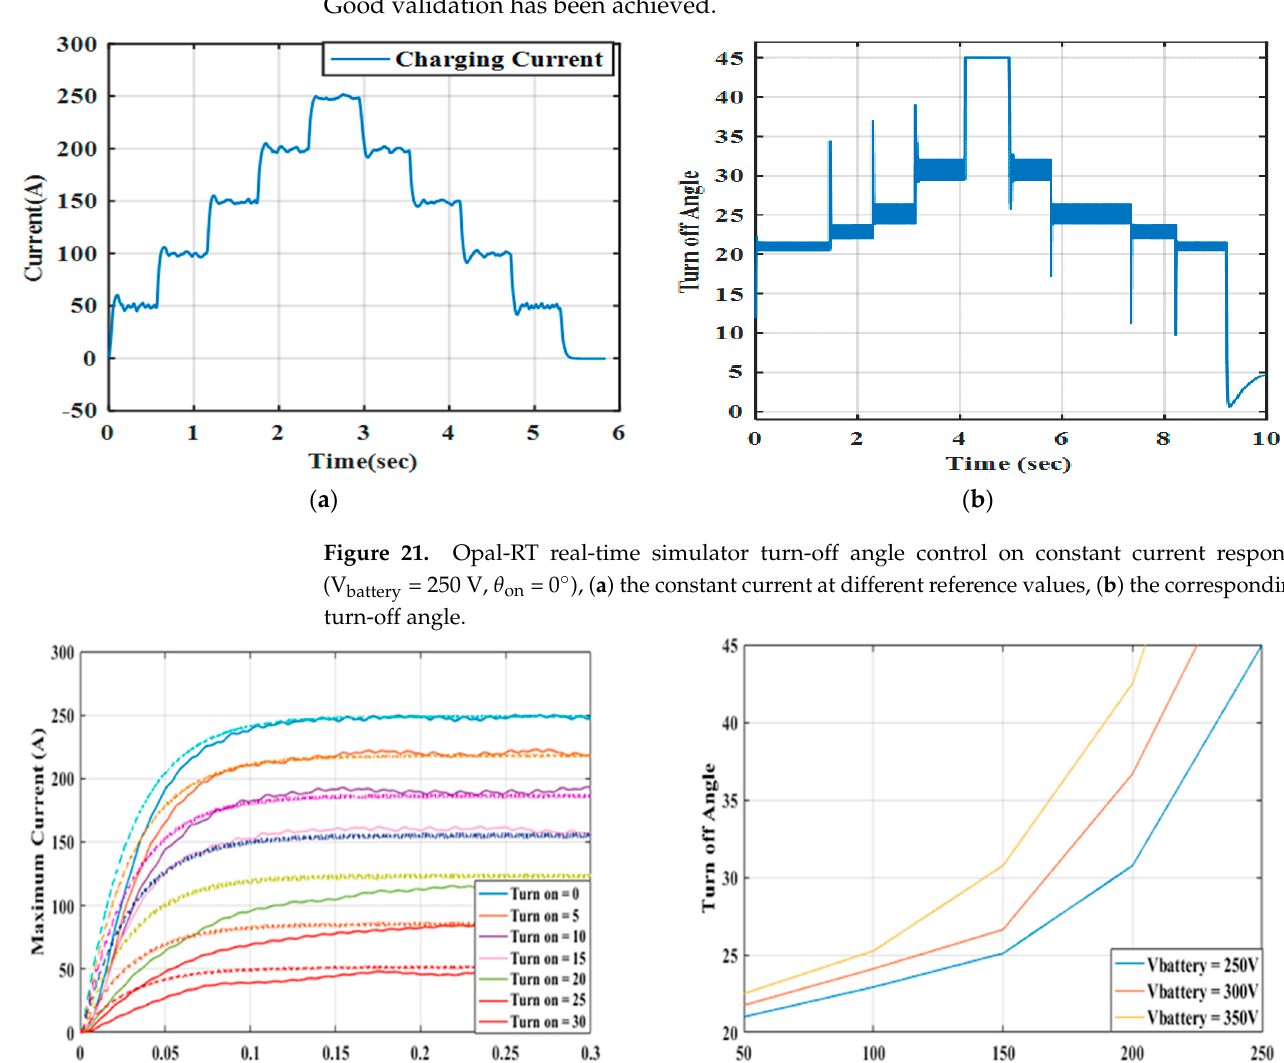
Figure 20. Control-hardware-in-the-loop platform: (1) Opal-RT real-time simulator, (2) OP8665 con- troller interface, (3) opal interface and monitoring, (4) DSP interface, (5) Oscilloscope. Output current responses at different reference signals and their corresponding turn- off angles are validated by the OPAL-RT simulator and shown in Figure 21. The response is similar to the Matlab/Simulink response. The maximum current generation is validated and shown in Figure 22a. Dash curves show the Simulink response compared to opal RT simulator solid curves. Validation has been performed for the turn-on control angle, where the output response for a constant current at different reference values is shown as solid curves in Figure 23a, which are compared with Matlab/Simulink response dashed curves. Good validation has been achieved.